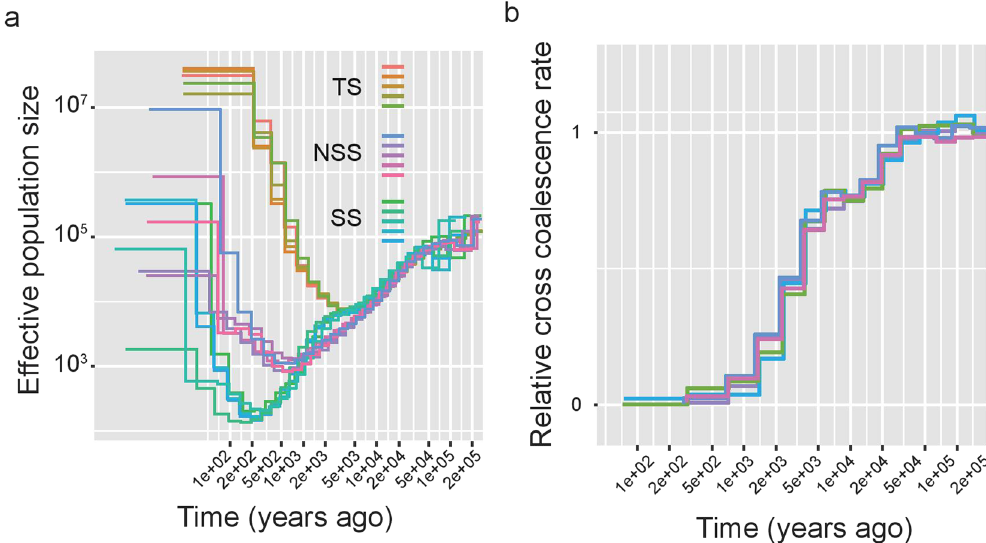
Figure 2. Population size and divergence inference using MSMC. ( a ) Population size estimation for the TS, NSS, and SS populations. For each population, five replicates were conducted with eight haplotypes. ( b ) The split time between TS and NSS was estimated from eight haplotypes (four haplotypes from each population). Five replicates were tested. To estimate the real split time and effective population size, we assumed a mutation rate of 3 × 10 − 8 and a generation time of one